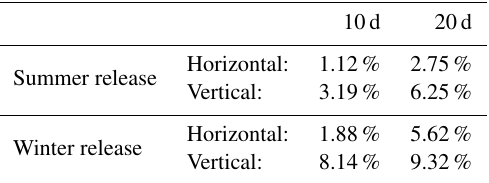
Table 1. Relative effect on horizontal and vertical particle positions after 10 and 20d of integration, averaged over 78803 particles re- leased over the whole Mediterranean at 1m depth, of replacing the actual seawater density by a nominal value ρ f = 1025kg/m 3